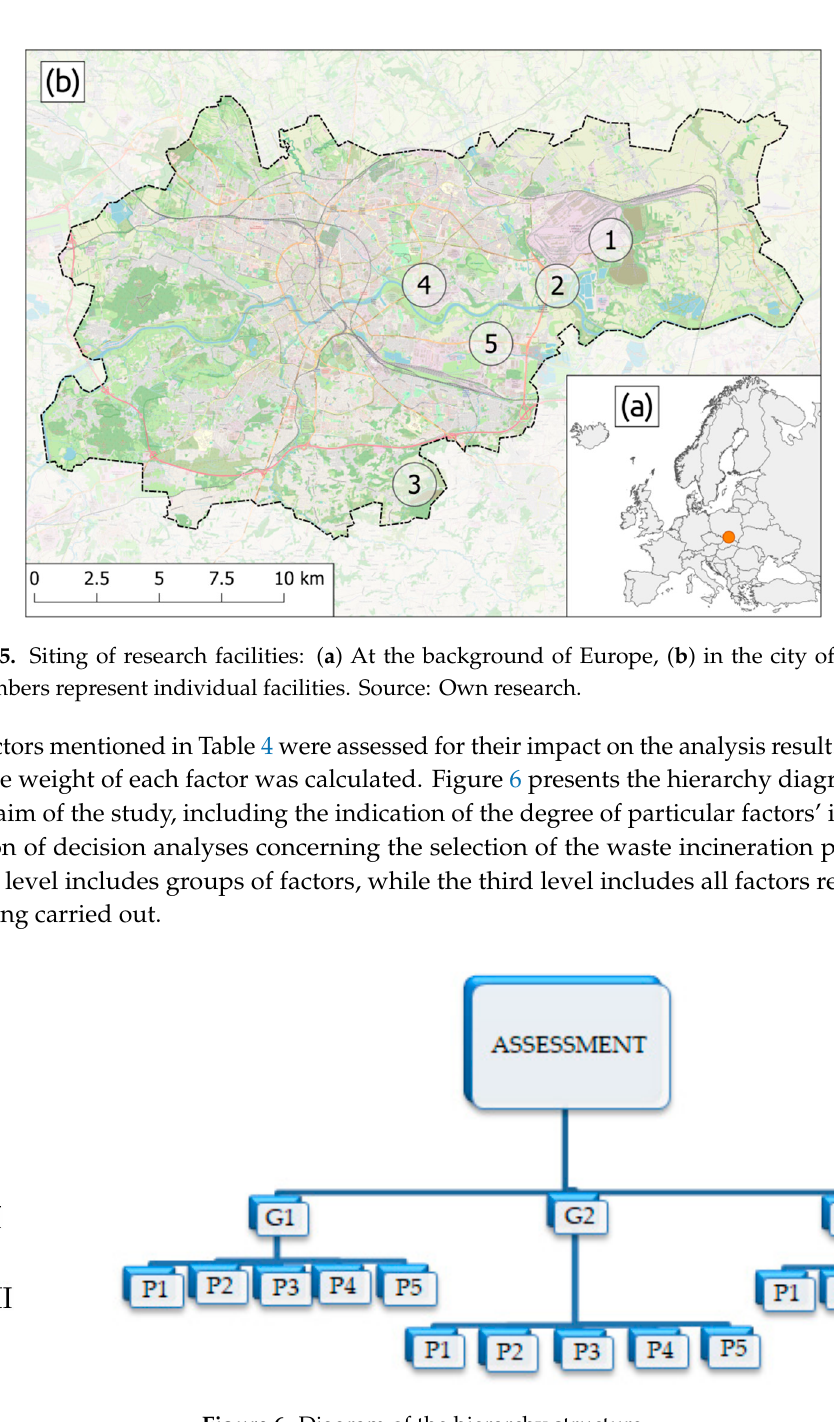
Figure 6. Diagram of the hierarchy structure.